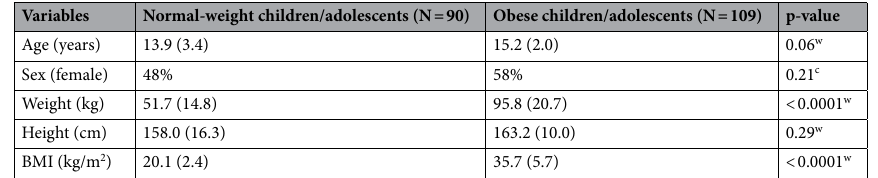
Table 1. Demographic and anthropometric characteristics in the normal-weight and obese groups (mean ± standard deviations). p-value—statistical significance computed by using Wilcoxon’s test w and the chi- square test c for a comparison between the two groups. BMI body mass